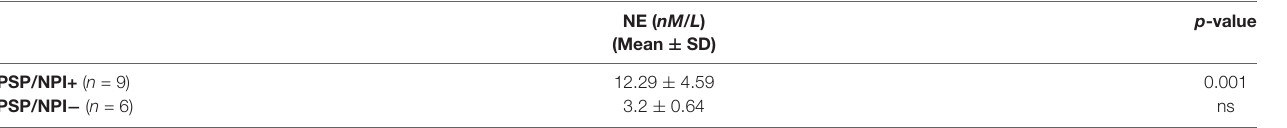
NE ( nM/L ) p -value (Mean ± SD)